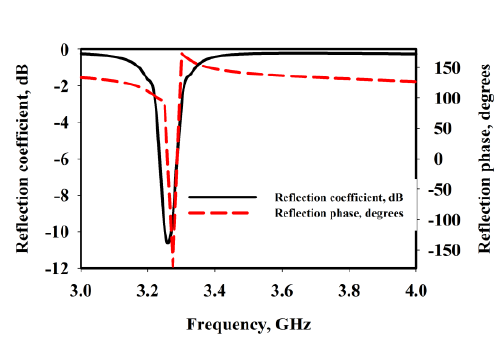
Figure 2: Reflection characteristics of the unit cell Reflection and transmission measurements on the structure constituting a single array of SRR and continuous wire array have been carried out by adopting the standard procedures. Transmission measurement consists of placing the